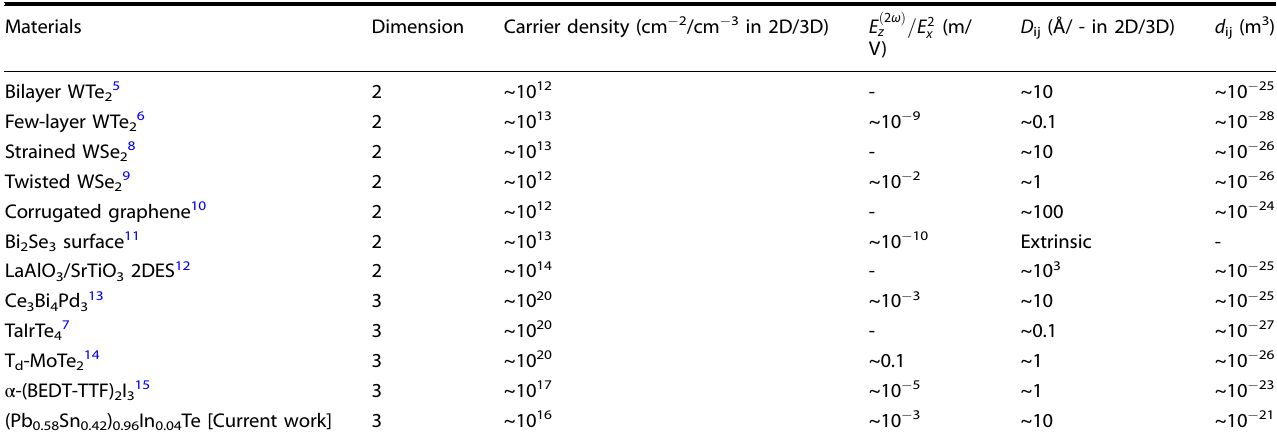
Table 1. The comparison of parameters of the NLHE among different materials. Materials Dimension